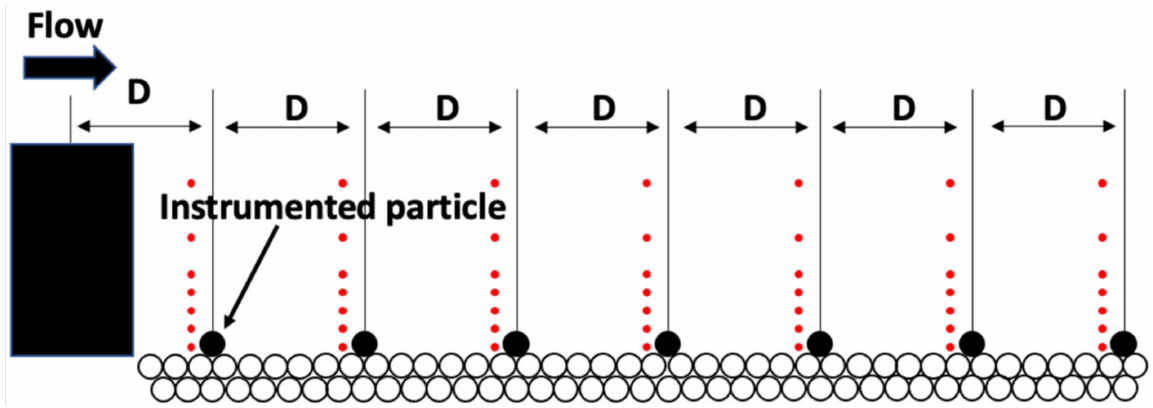
Figure 6. Sketch of the experimental test section showing the flow measurement grid comprising of point locations of ADV velocity measurements (red points) downstream the vegetation element (represented with a black rectangle on the upstream), and the bed surface locations for placing the instrumented particle (black